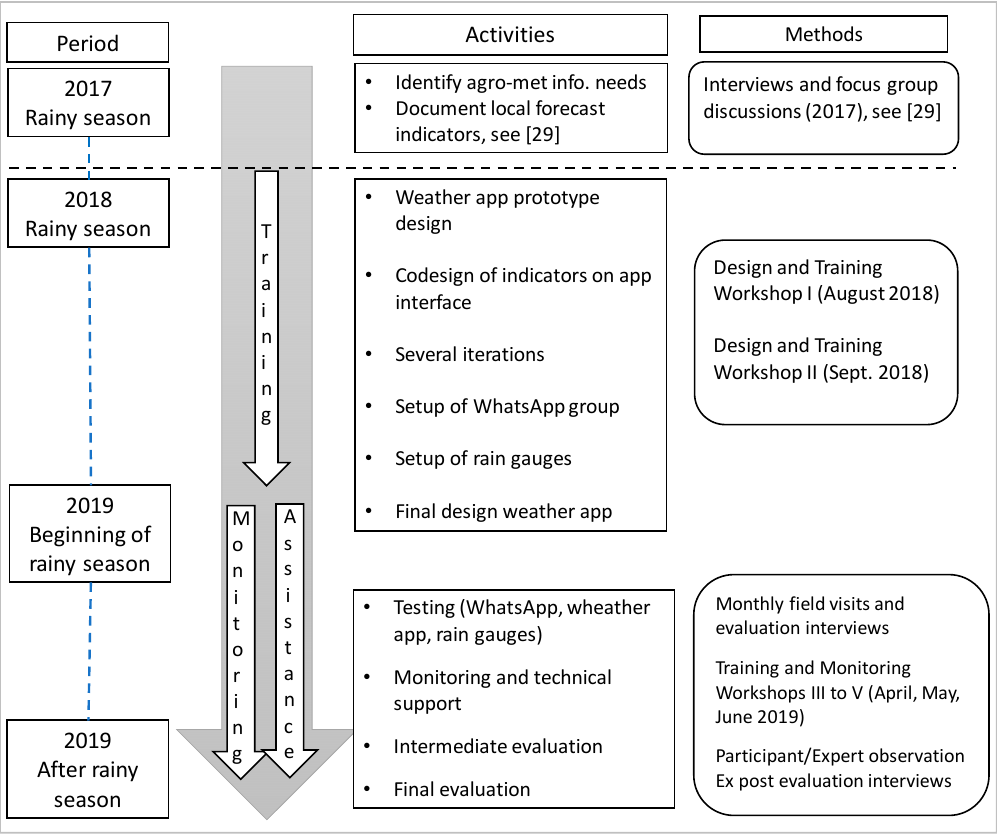
Figure 4. Chronology of the coproduction work carried out in Ada East District, Ghana. Activities and methods for the 2017 rainy season, above the horizontal dashed line, are covered in previous studies, as part of the Waterapps project. They are, therefore, not included in the present study.